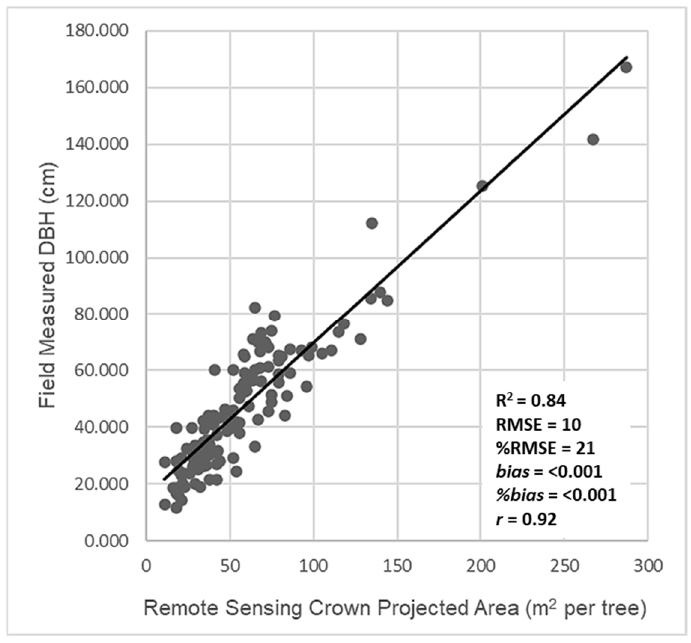
Figure 5. Constructed model of the OLS linear regression of field measured tree diameter at breast height (DBH) and the remote sensing derived crown projected area (CPA).